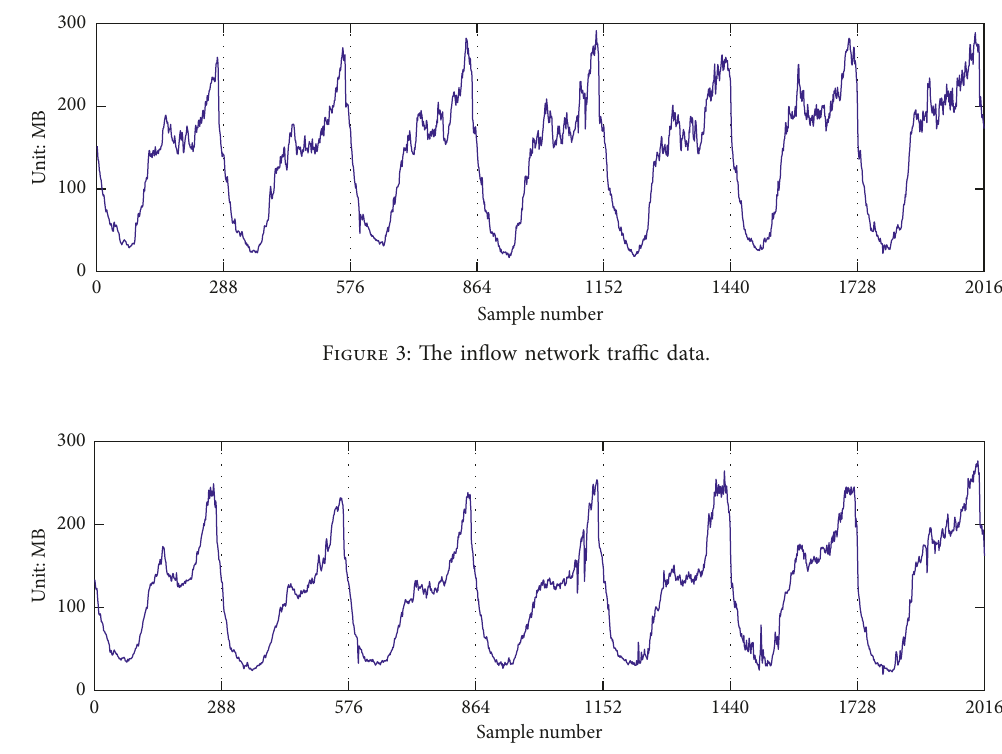
Figure 4: The outflow network traffic data.